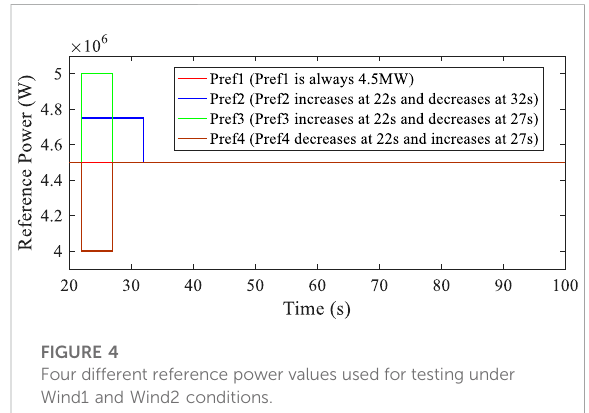
FIGURE 4 Four different reference power values used for testing under Wind1 and Wind2